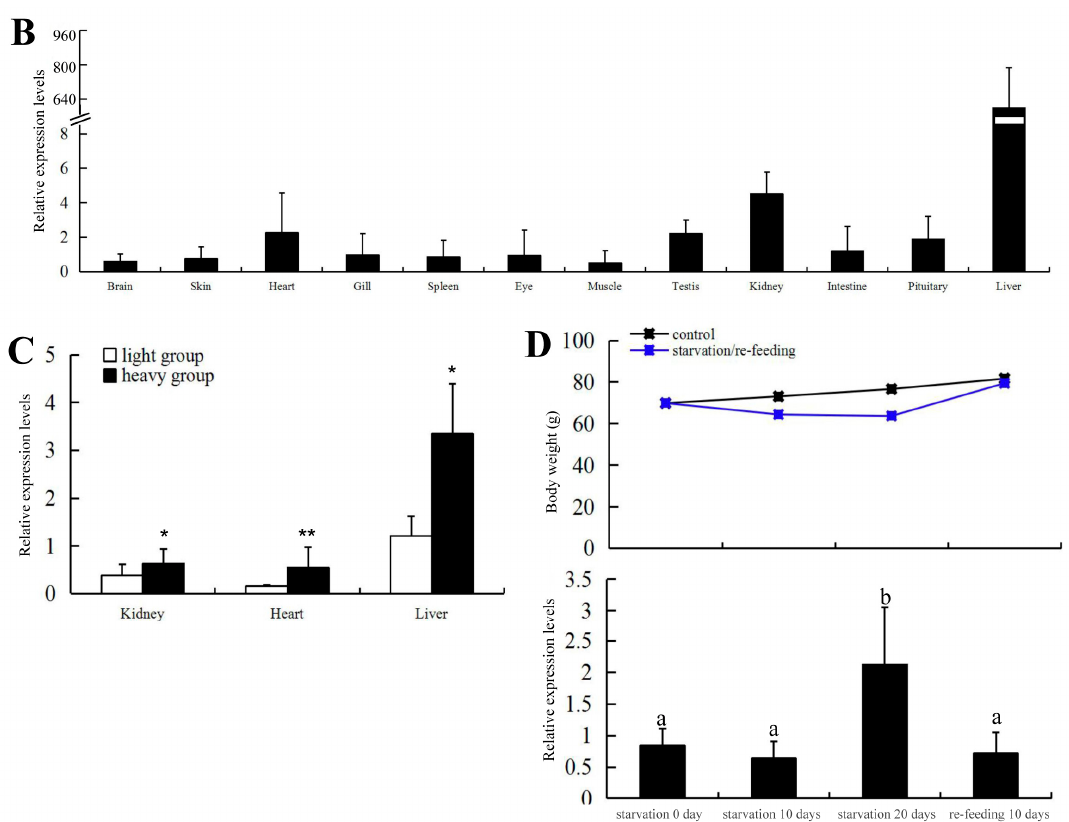
Figure 3. The relative expression levels of apoA-Ib in Cyprinus carpio . ( A ) The relative expression during embryonic development; ( B ) The relative expression in different tissues; ( C ) Comparative expression analysis of kidney, heart and liver between light and heavy body weight groups. Significant differences at p < 0.05 and p < 0.01 are labeled with * and **, respectively; ( D ) Body weight and expression analysis of the individuals participated in the compensatory growth test. Significant differences are labeled with different lowercase letters. Data are shown as the mean ± SEM ( n = 5).